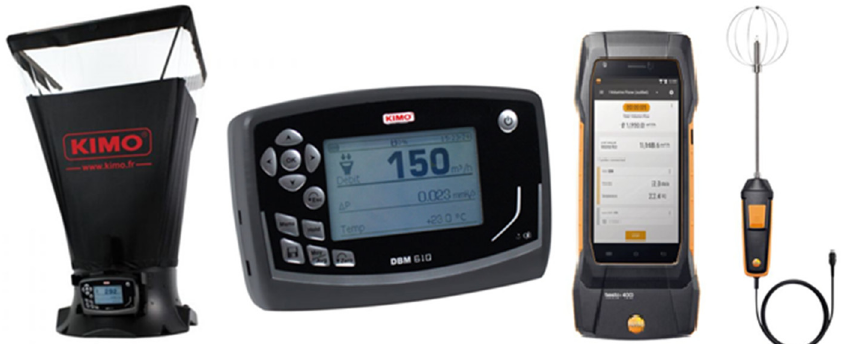
Figure A1. Figure A1. Instruments.